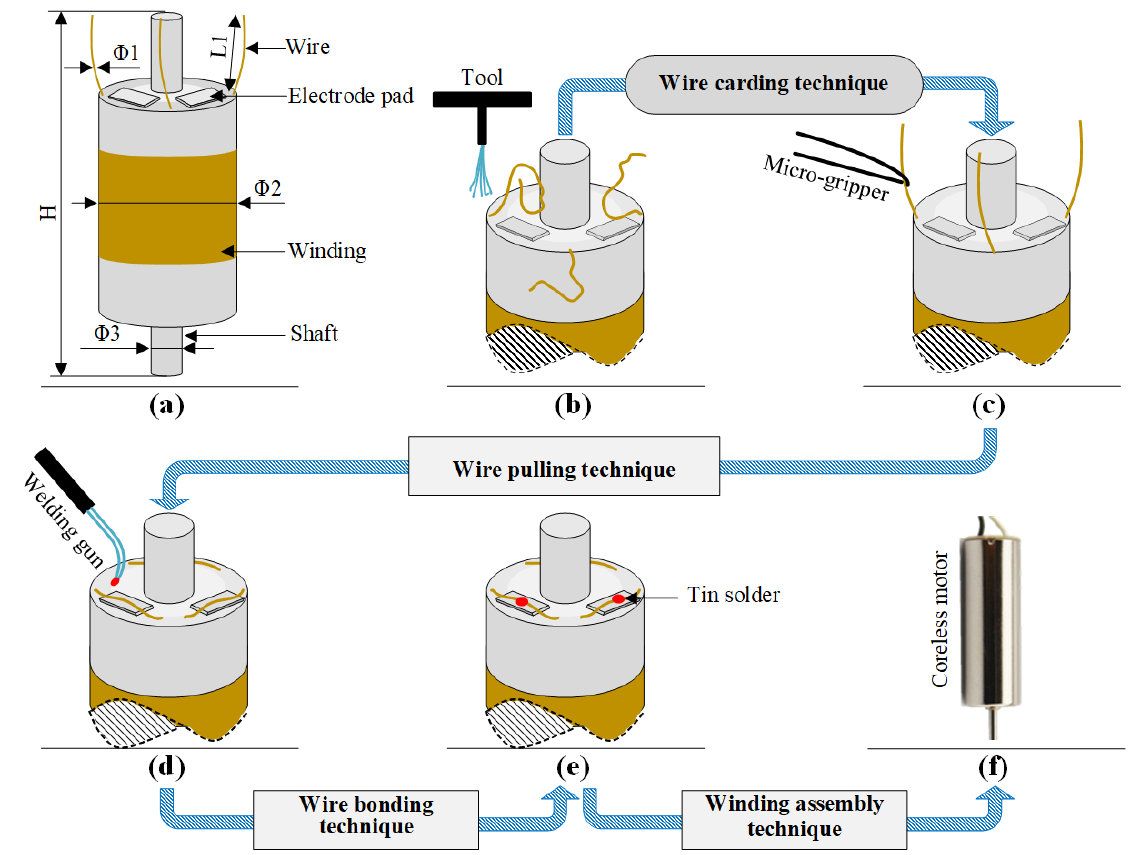
Figure 1. Coreless motor’s winding and its assembly process: ( a ) The winding of the coreless motor. ( b ) Electrode wires with random shape and attitude (S&A). ( c ) Electrode wires are carded to the target S&A through an automated wire carding technique. ( d ) Electrode wires are dragged and placed on the pads through an automated wire pulling technique. ( e ) Electrode wires are soldered through an automated wire bonding technique. ( f ) The final coreless motor is assembled through an automated winding assembly technique. Table 1. Geometric dimensions of the coreless motor’s winding in Figure